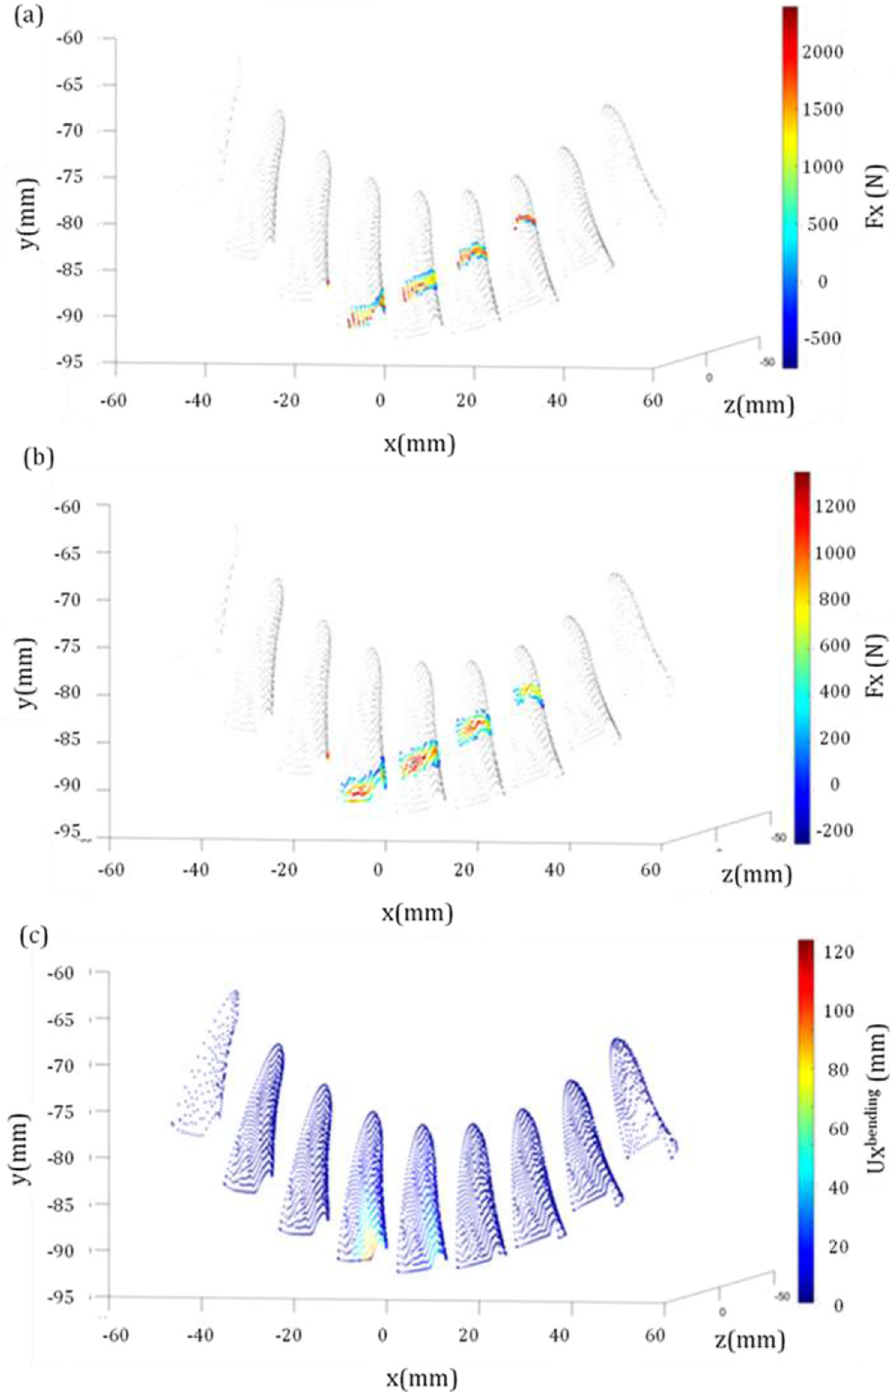
Fig. 6. ABAQUS simulations obtained with 750 Nm torque on the worm (only 9 teeth are shown). (a) Nodal force fi eld in ROUVISLAM mesh, (b) Nodal force fi eld in ABAQUS mesh, (c) Residual bending